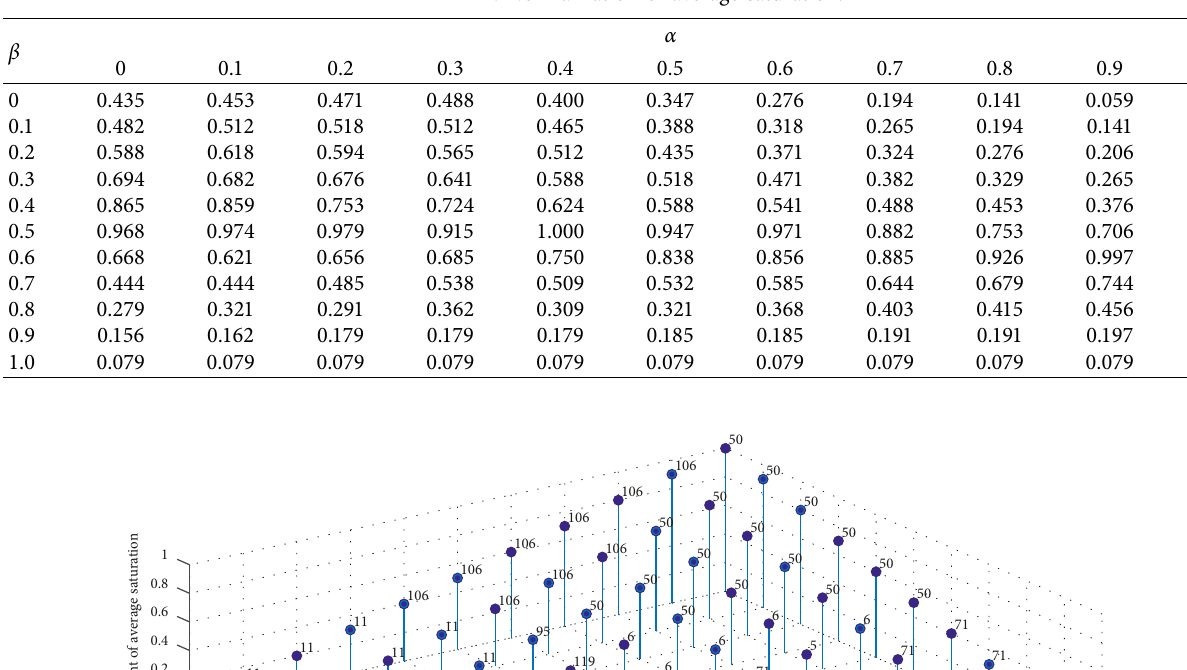
Table 11: Normalization of average saturation.